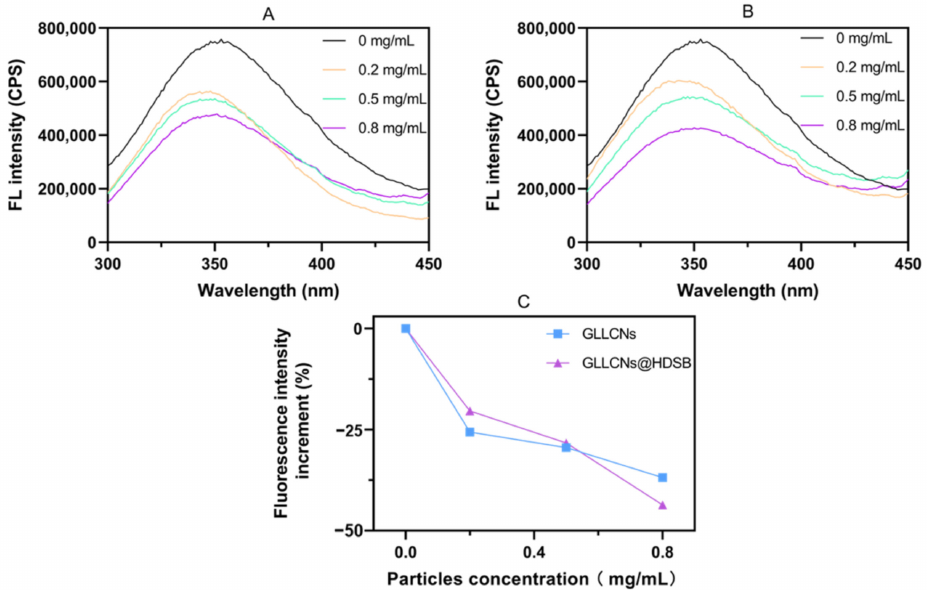
Figure 3. ( A , B ) Fluorescence spectra of BSA incubated with GLLCNs ( A ) and GLLCNs@HDSB ( B ) at different concentrations. ( C ) The peak fluorescence increment of BSA incubated with GLLCNs and GLLCNs@HDSB at different